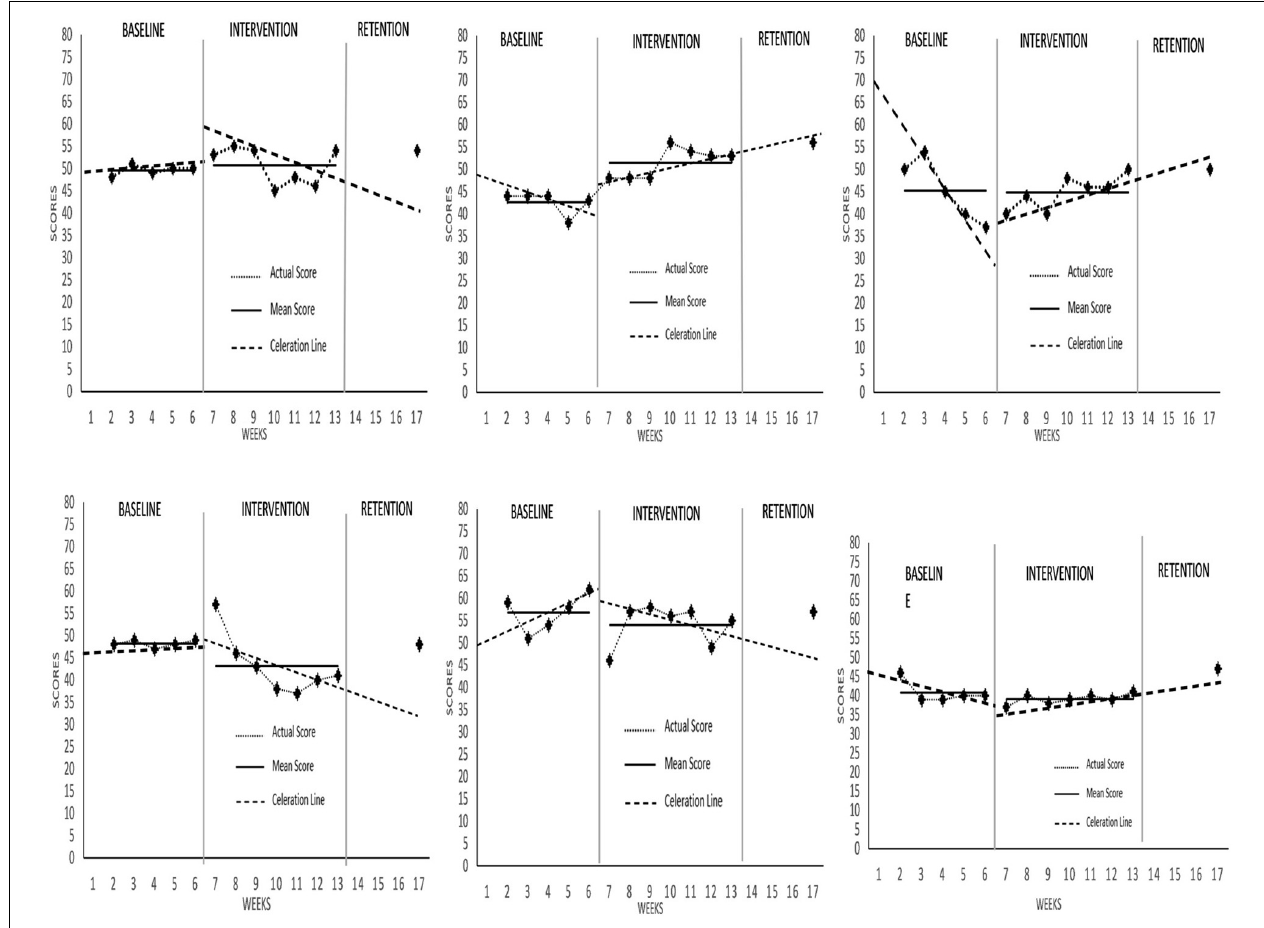
FIGURE 4 | Self-rated performance scores across all